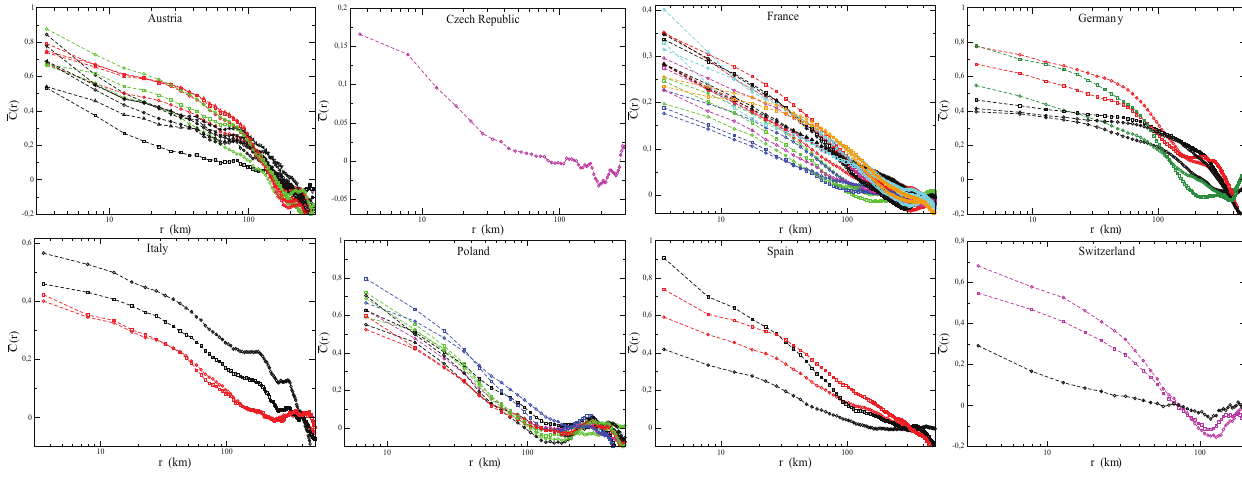
Figure 8. Normalized spatial correlations ~ CC ( r ) of t ’ ~ t { m N for all countries for which the geographic position of cities is available. The correlation is normalized by the variance of t ’ , such that ~ CC ( r ~ 0) : 1 . For labels of elections, see Figs. 1, 2.